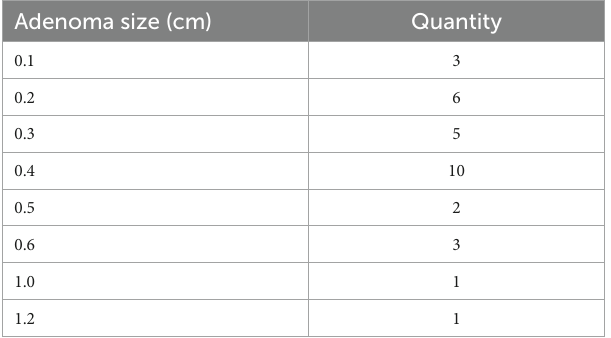
TABLE 1 Tubular adenoma size in adenoma patients in the adenoma group.